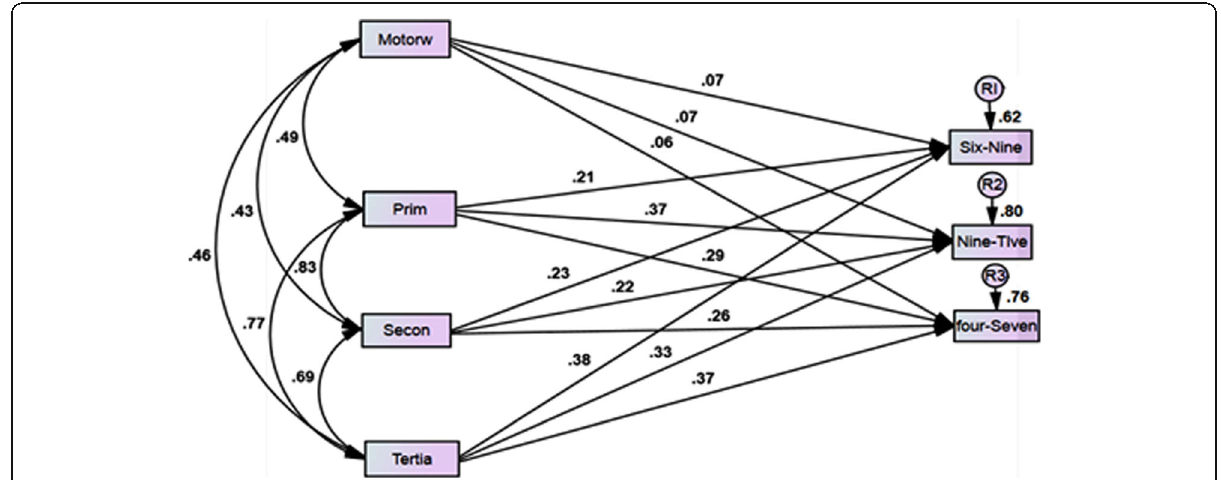
Fig. 4 The relationship between the various road types and peak and off-peak hours (private cars and taxi